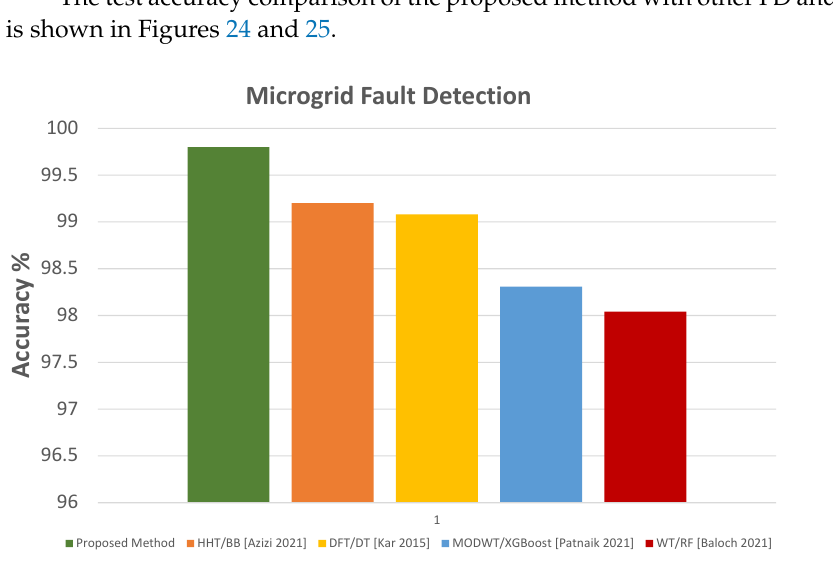
Figure 24. Accuracy comparison with other FD methods